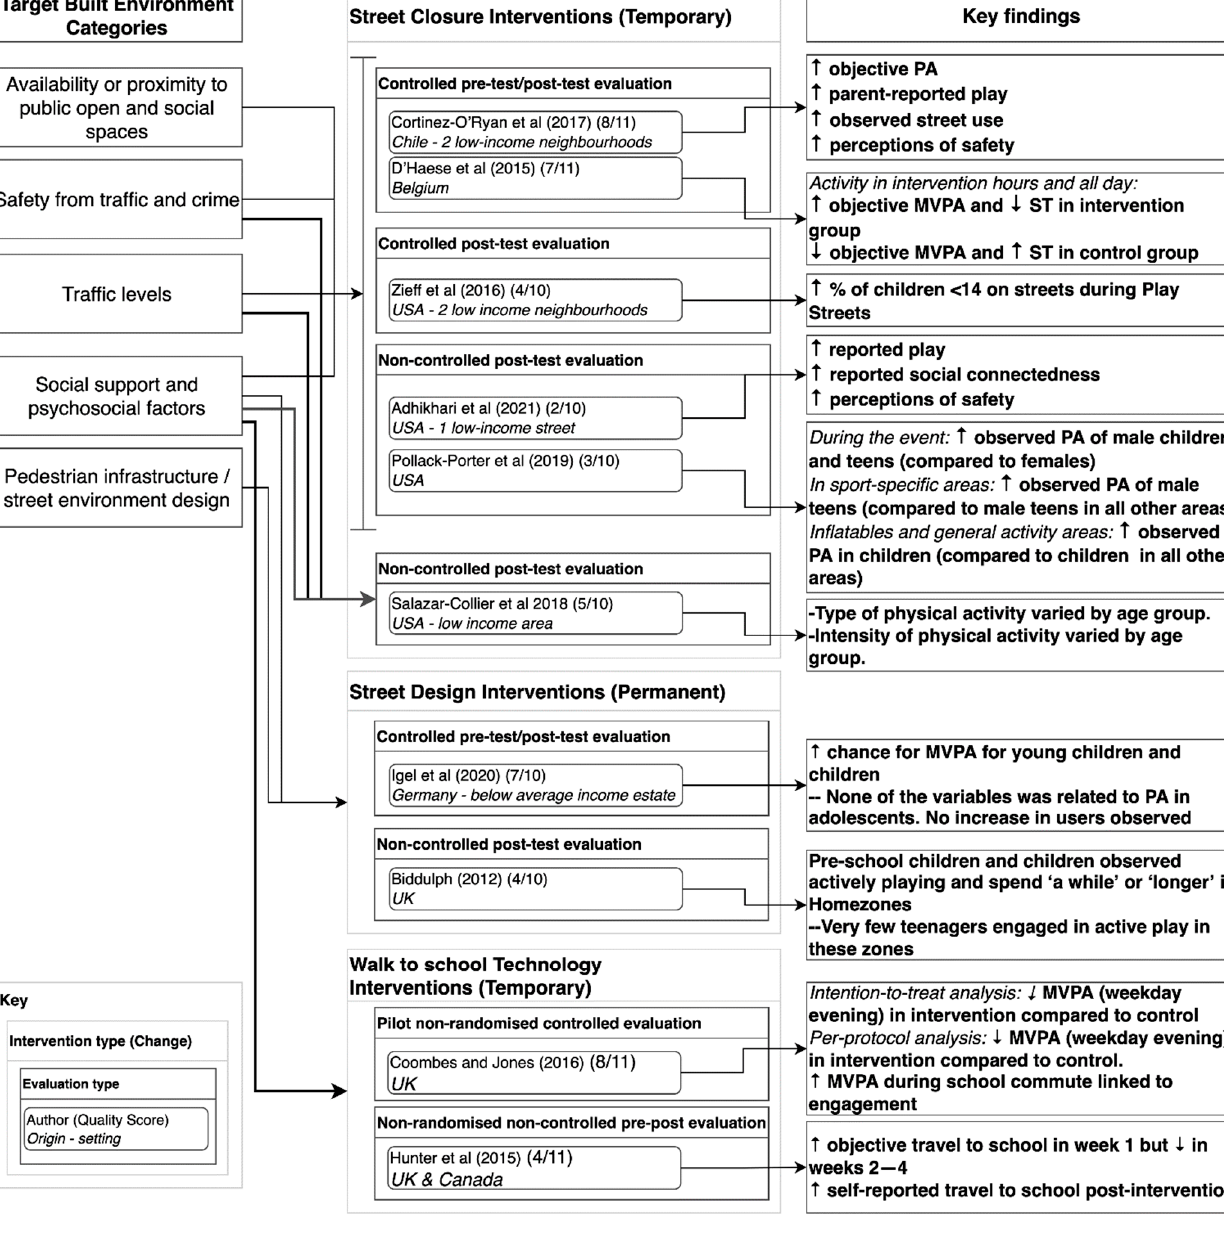
Figure 2. Targeted built environment categories, interventions and key findings.